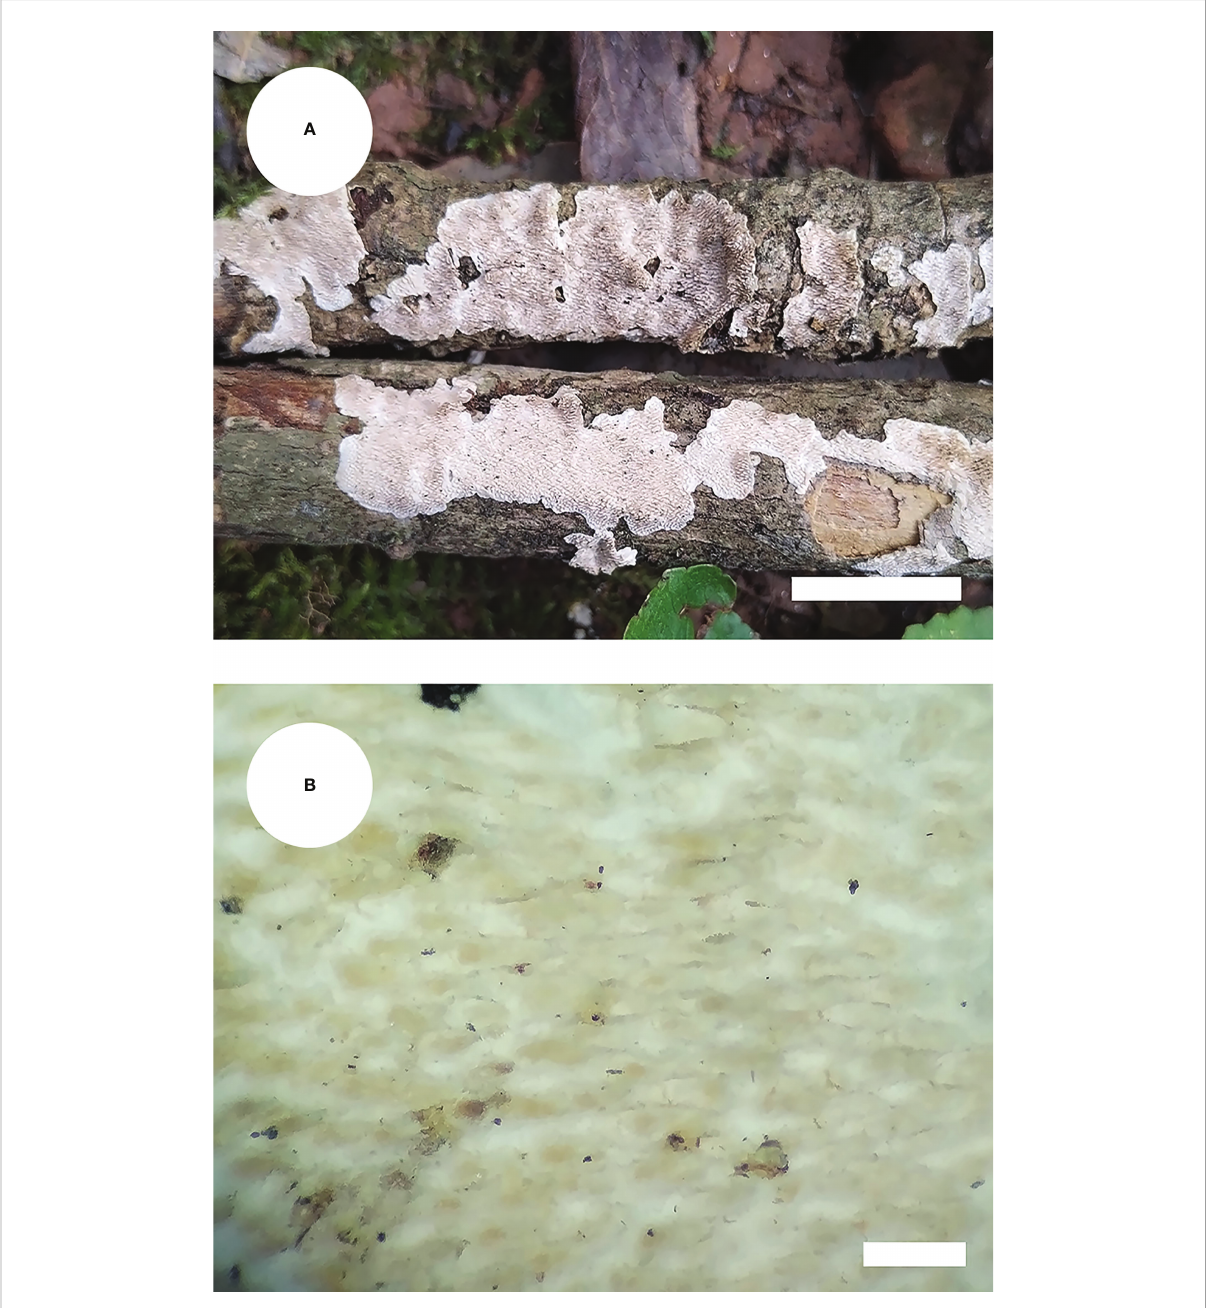
FIGURE 7 Basidiomata of Steccherinum subtropicum (holotype). Bars: (A) 1 cm; (B) 0.5